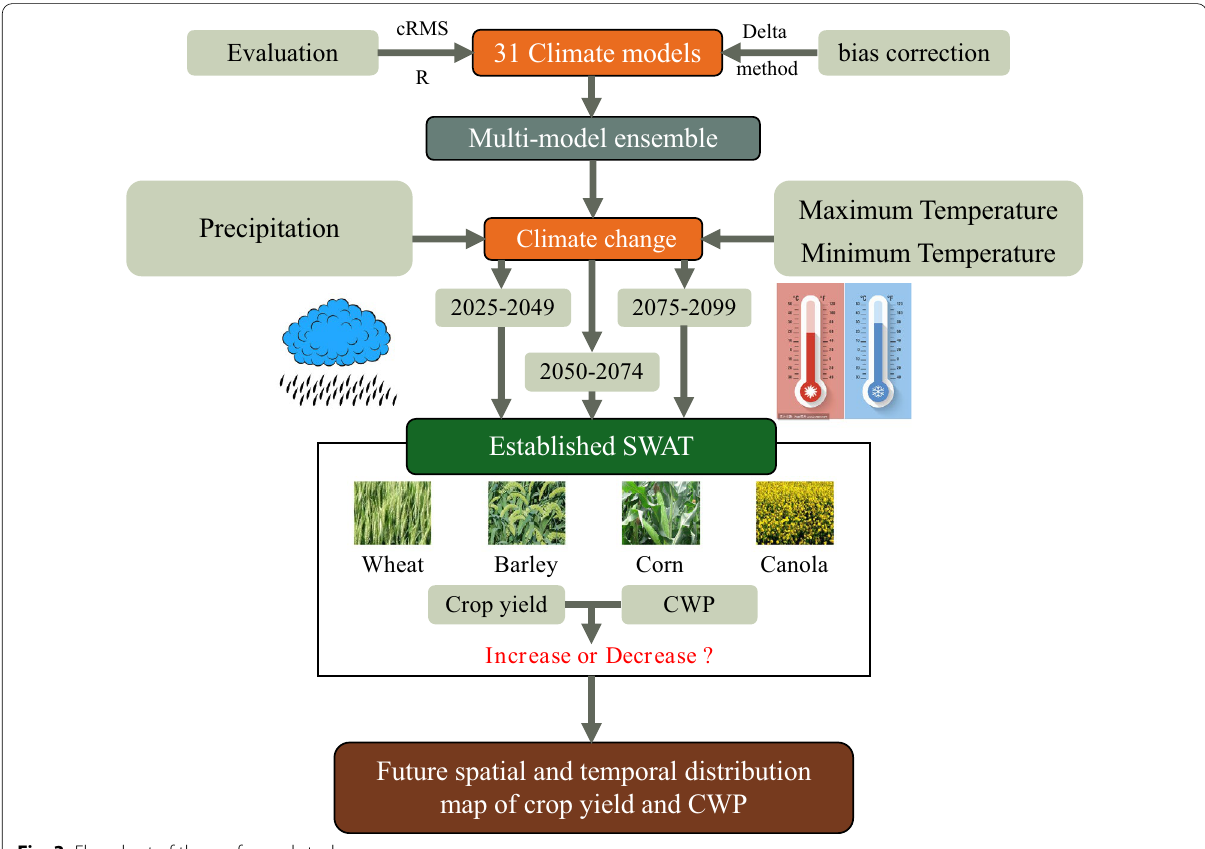
Fig. 3 Flowchart of the performed